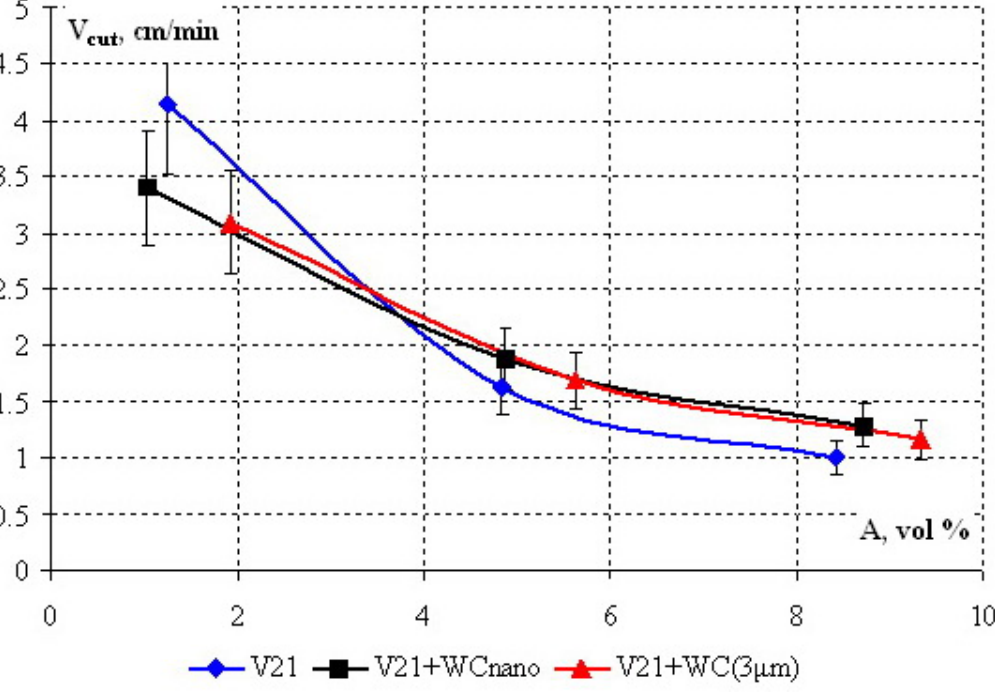
vs . armature content A (vol %) for diamond segments with a Figure 7. Cutting speed V cut V21 binder dispersion-strengthened with nano- and micro-sized WC particles.